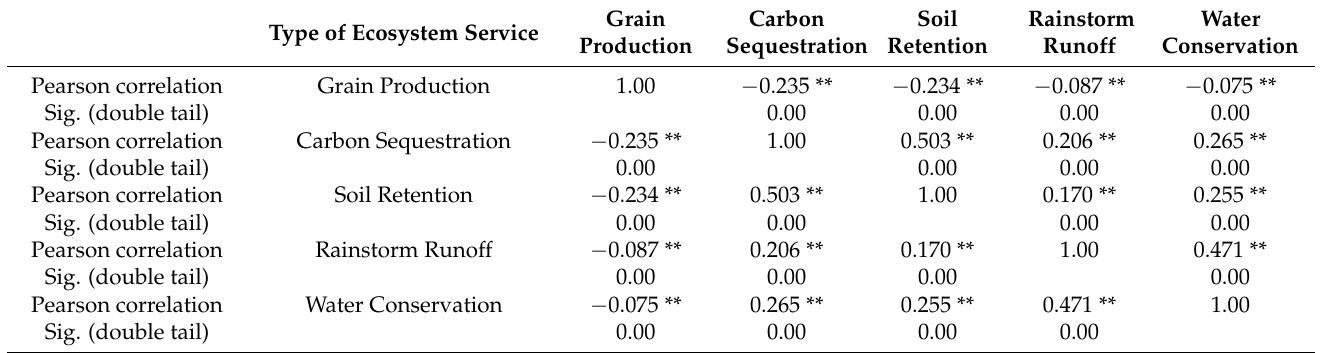
Table 5. Pearson Correlation Coefficient for Ecosystem Service in the Greater Bay Area